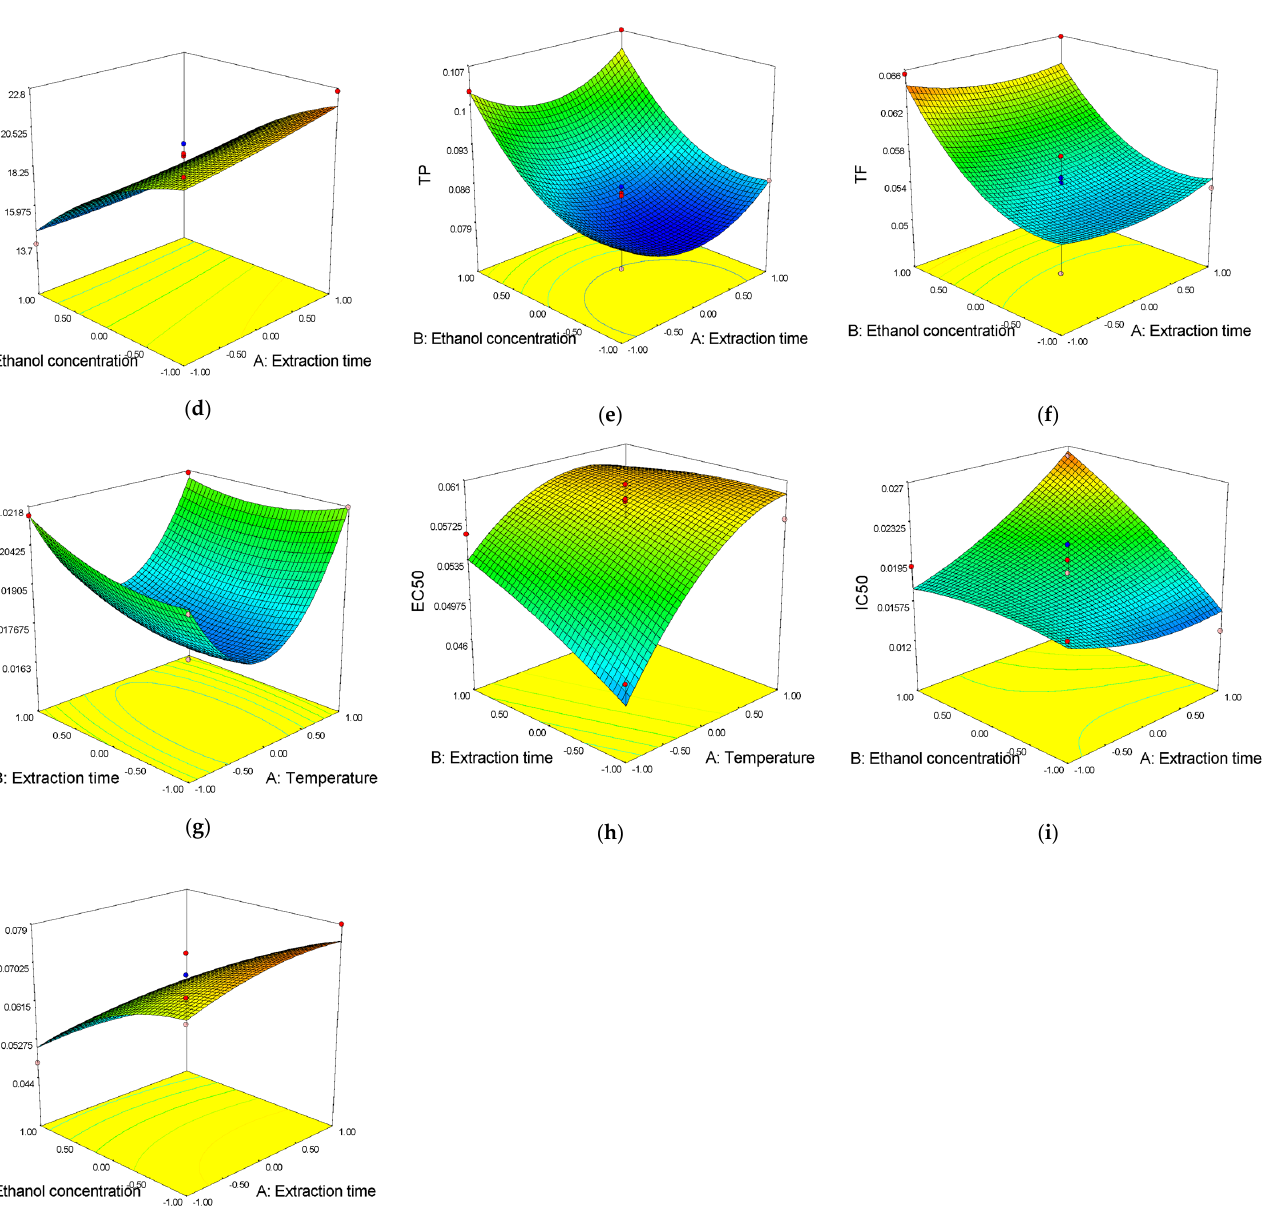
Figure 1. Response surface plots showing combined effects of temperature and extraction time on Y, TP, TF, IC 50 and EC 50 in UAE extracts ( a – c , g , h ) and combined effects of extraction time and ethanol concentration on Y, TP, TF, IC 50 and EC 50 in MAE extracts ( d – f , i , j